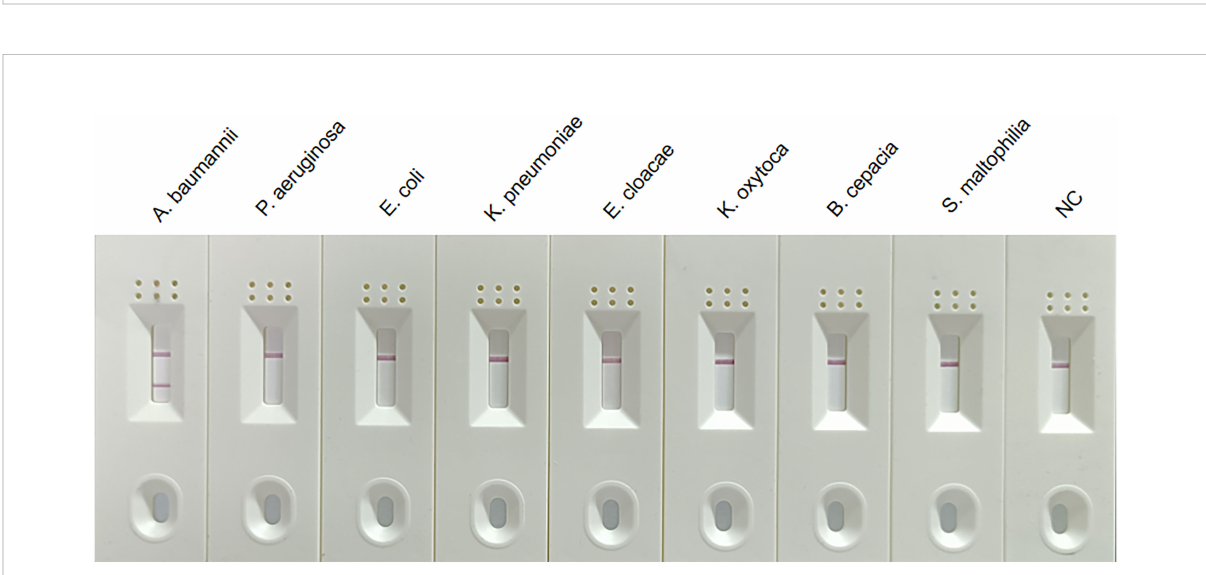
FIGURE 2 Speci fi city of the MIRA-LFD assay. Results showed that only the positive control sample and A. baumannii isolates produced ampli fi cation signals, whereas other non- A. baumannii isolates and negative control produced no ampli fi cation signals. NC, negative control; C, control line; T, test